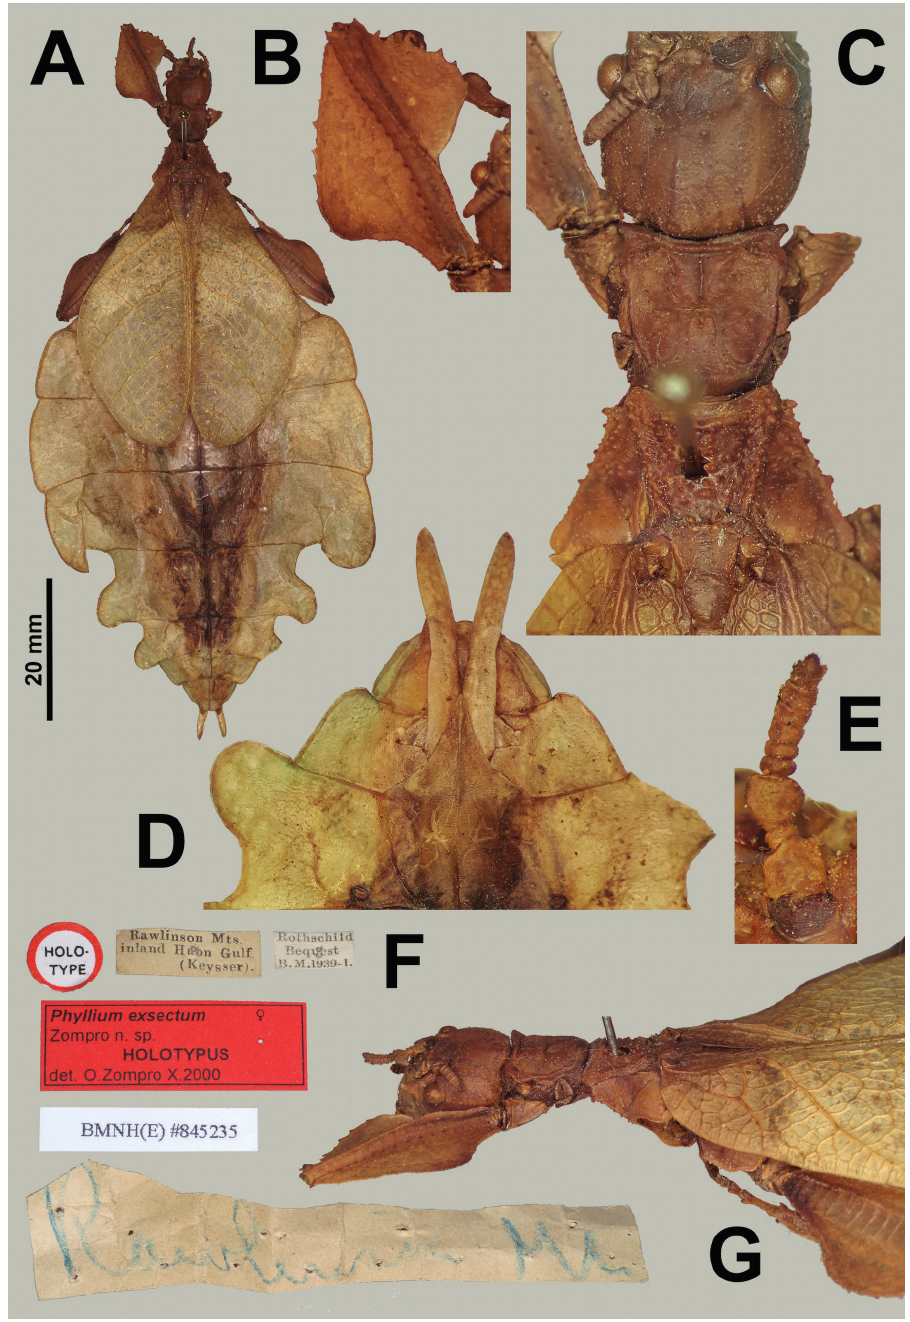
Figure 9. Rakaphyllium exsectum comb. nov. holotype female (NHMUK) A habitus, dorsal B pro- femora, dorsal C details of head through thorax, dorsal D genitalia, ventral E details of antenna, dorsal F associated data labels G details of head through thorax, dorsolateral. Scale bar only associated with A . Photographs A, F, G taken by Paul Brock (United Kingdom), other photographs taken by first